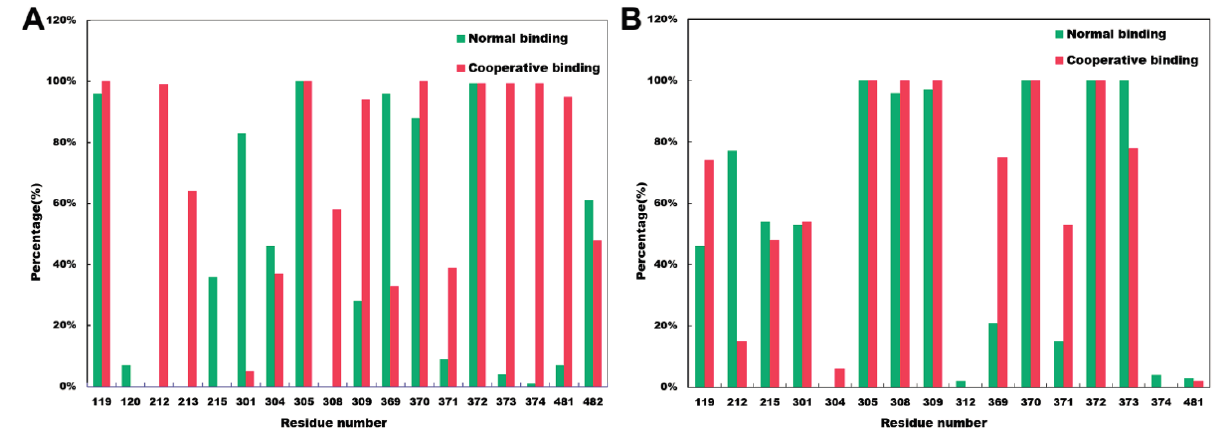
Figure 4. Percentage of frames over the simulation trajectories that have close contacts of less than 5 Å between the first KLN and the residues in the active site for both normal and cooperative binding models in ( A ) CYP3A4t structure and ( B ) CYP3A4w structure. For the CYP3A4t structure, the close contacts formed by Arg212, Phe213, Gly306 and Glu374 were only detected in the cooperative binding model (Figure 4A). In the cooperative binding model, the side chain orientation of Arg212 was quite different from the normal binding model: Arg212 faced to the imidazole group of the dioxolan moiety of the first KLN, forming strong hydrophobic interactions (Figure 2A). As near to Arg212, Phe213 played an important role to stabilize Arg212 in the imidazole-facing